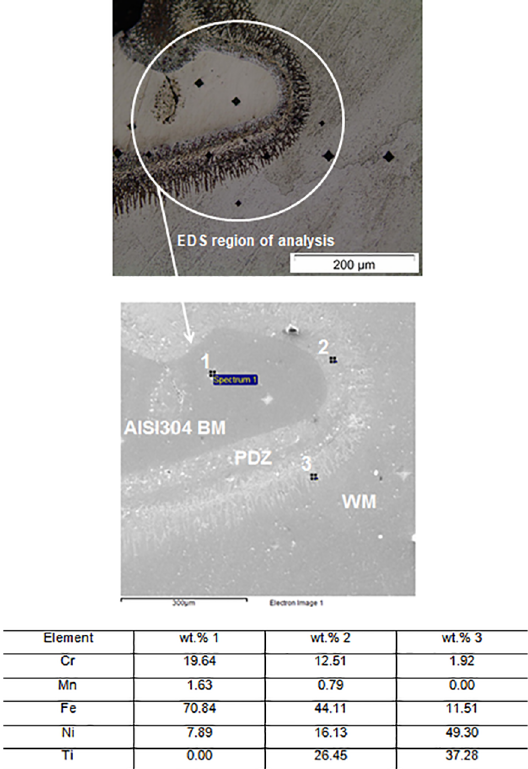
Figure 9. EDS analysis of the D11 dissimilar joint.